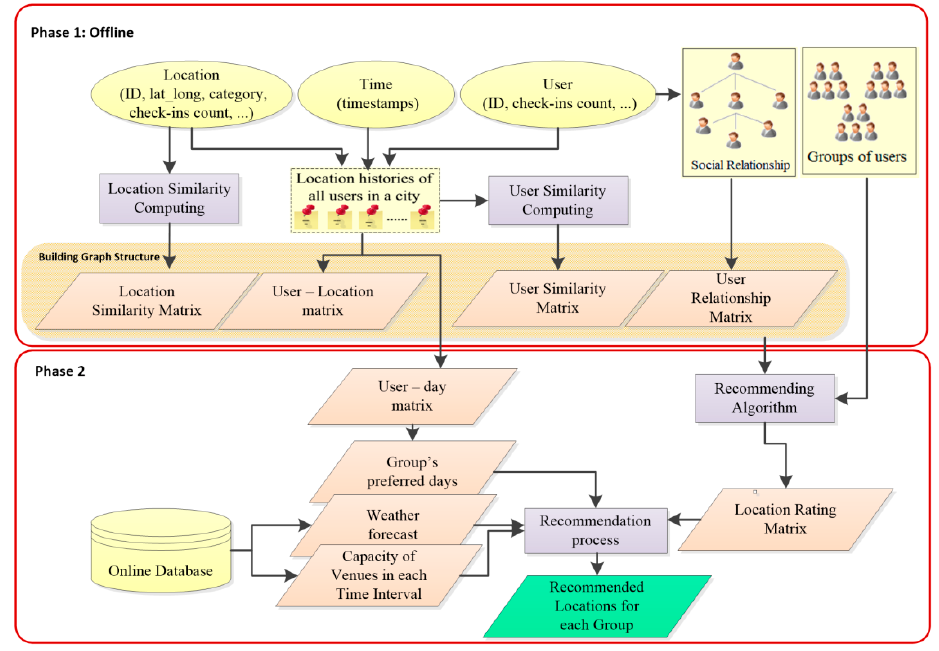
Figure 1. The system framework of proposed context-aware location recommendation for